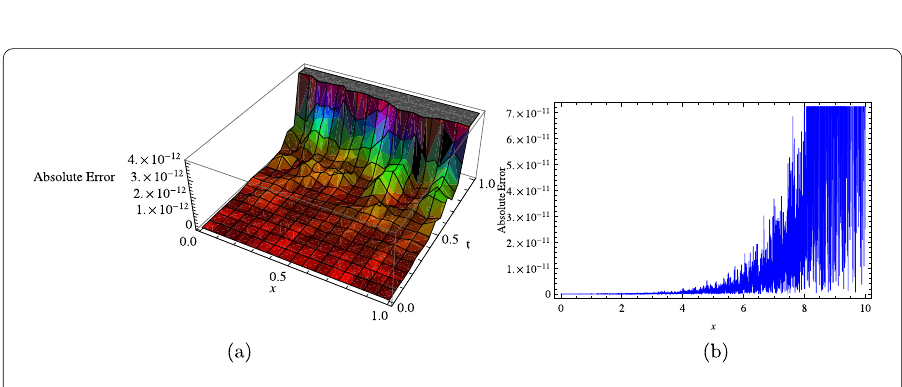
Figure 3 Plot of the absolute error of TFNWS equation when (cid:2) = –1. ( a ) E 4 ( η ) = | η ( x , t ) – η 4 ( x , t ) | . ( b ) The corresponding E 4 ( η ) when t = 1